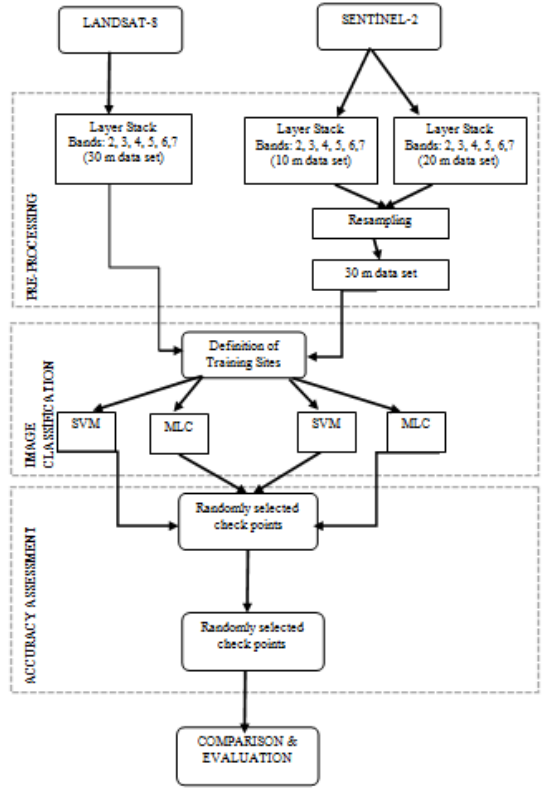
Figure 2. The whole flow chart of this